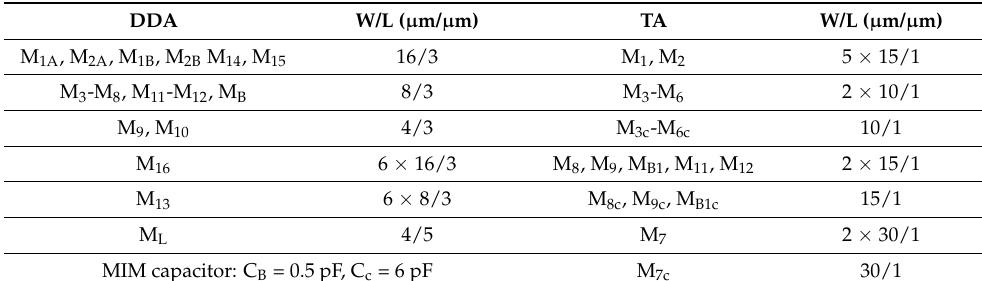
Table 3. Transistor aspect ratio of the DDTA.